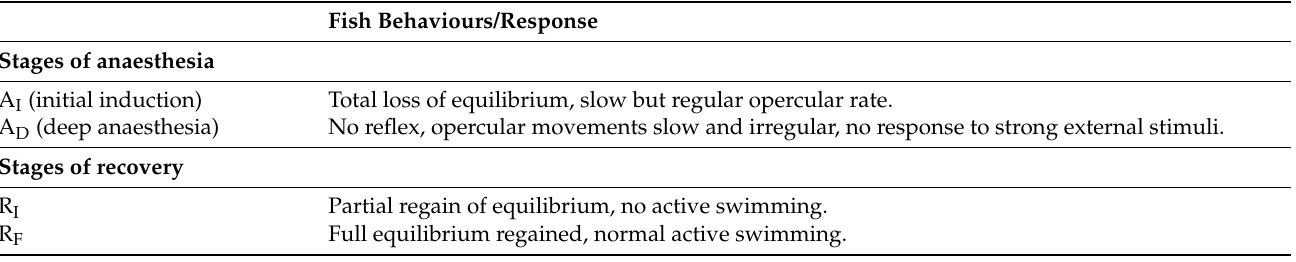
Table 1. Stages of anaesthesia (A) and recovery (R) in fish [21]. Fish